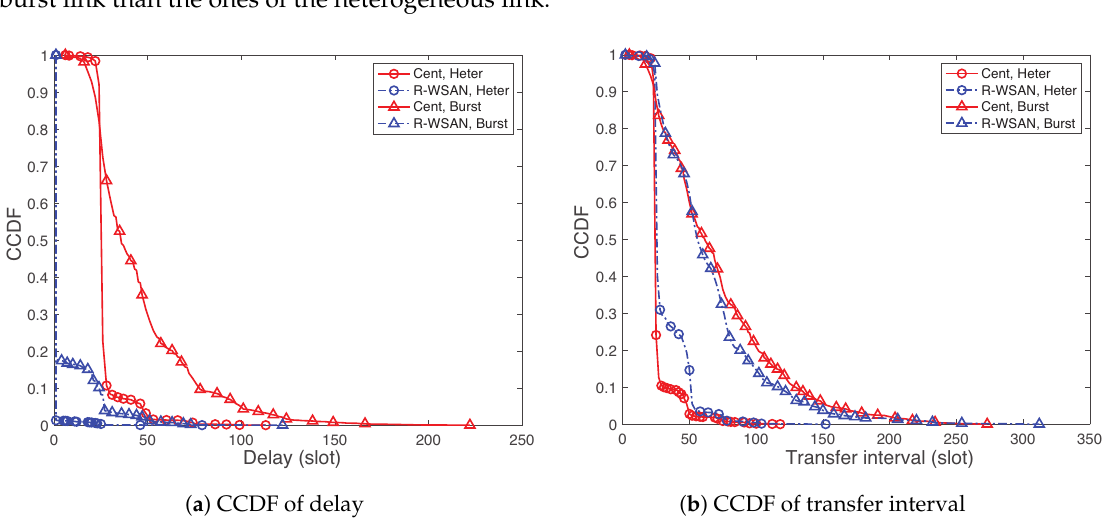
Figure 13. CCDF of delay and transfer interval using R-WSAN and the centralized protocol with different heterogeneous and burst links. Please note that the solid line and dotted line report the performance using the centralized protocol and R-WSAN, respectively, unless it is specified in each simulation. R-WSAN provides the significantly better feedback delay performance with respect to the one using the centralized